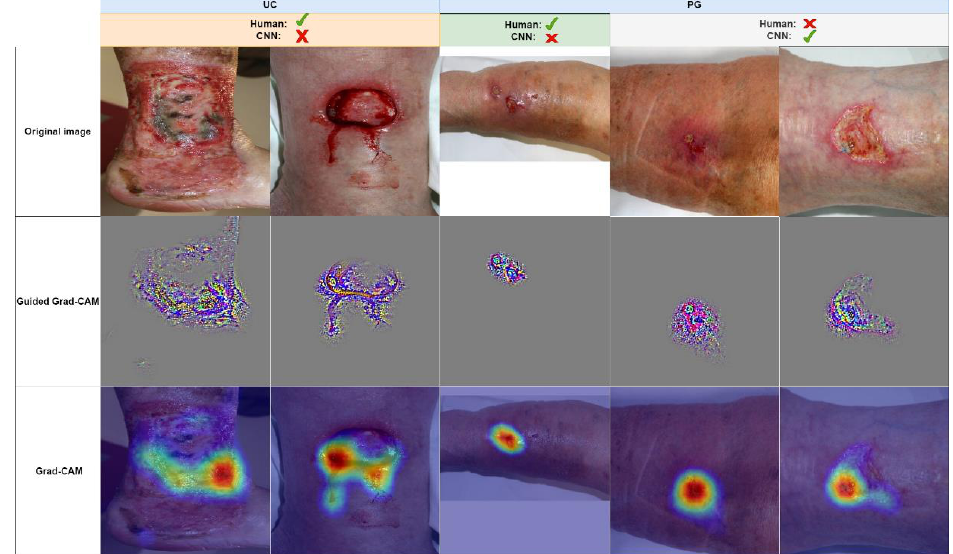
Figure 4. A few examples of images from the man vs. machine comparison, which were either misdiagnosed by humans or the network (correct majority diagnoses are indicated by a green checkmark, incorrect diagnoses by a red cross). Images are grouped in true diagnosis UC and PG. Guided Grad-CAM and Grad-CAM highlight the structures and areas that would lead the network towards a PG diagnosis. For the wrong UC interpretation (two leftmost columns), the CNN is misled by only small parts of the wounds, whereas for the correct PG diagnoses (two rightmost columns), the CNN accounts for the reddish area surrounding the lesion and the irregular wound border in the bottom left wound area.